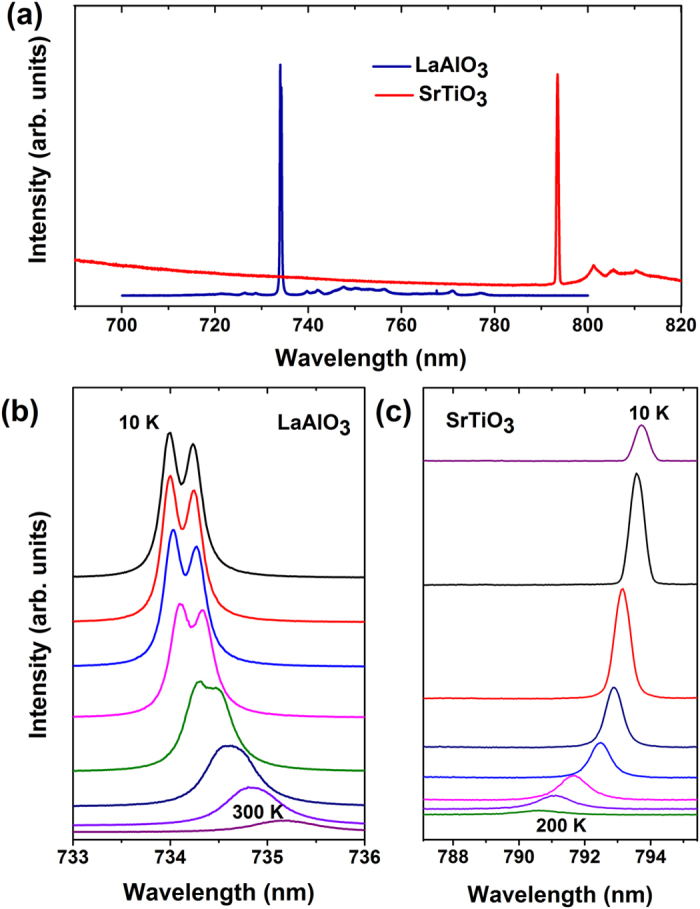
(a) Ultra-Sharp PL lines of LaAlO3 and SrTiO3 have been shown to exist in the near infrared energy band from 1.5 eV to 1.7 eV at 40 K. The evolution of the PL spectra for LaAlO3 and SrTiO3 for various temperatures have been shown in (b,c) respectively. The two sub-peaks in LaAlO3 is due to its twinning17. It is interesting to note the opposite trends in the peak shifts as a function of temperature.